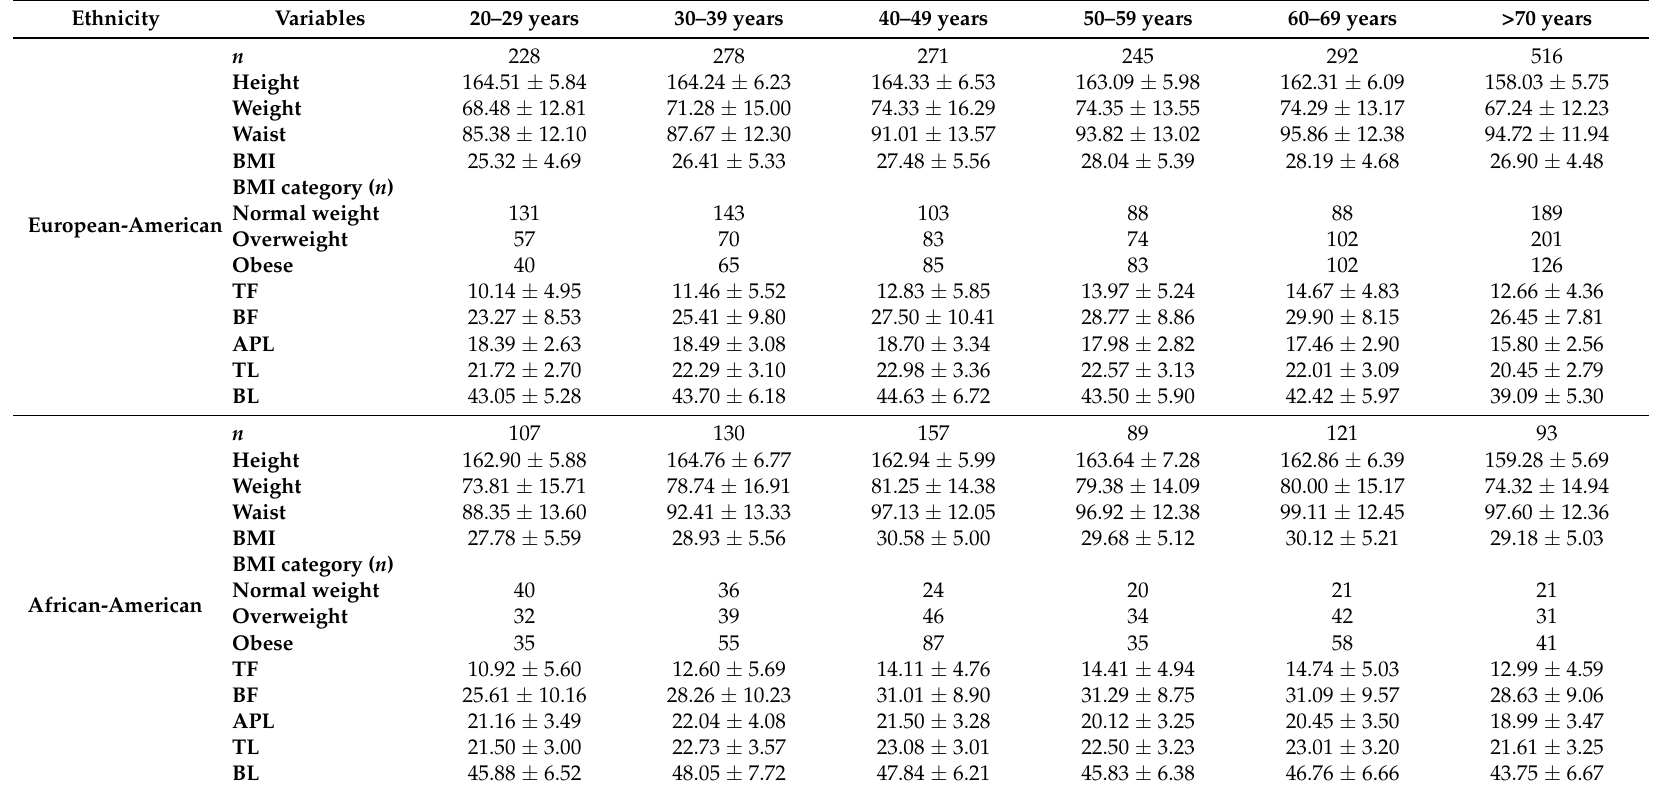
Table 5. Women’s segmental body composition variables (mean ± standard deviation) obtained by DXA in NHANES and classified by age and ethnicity.